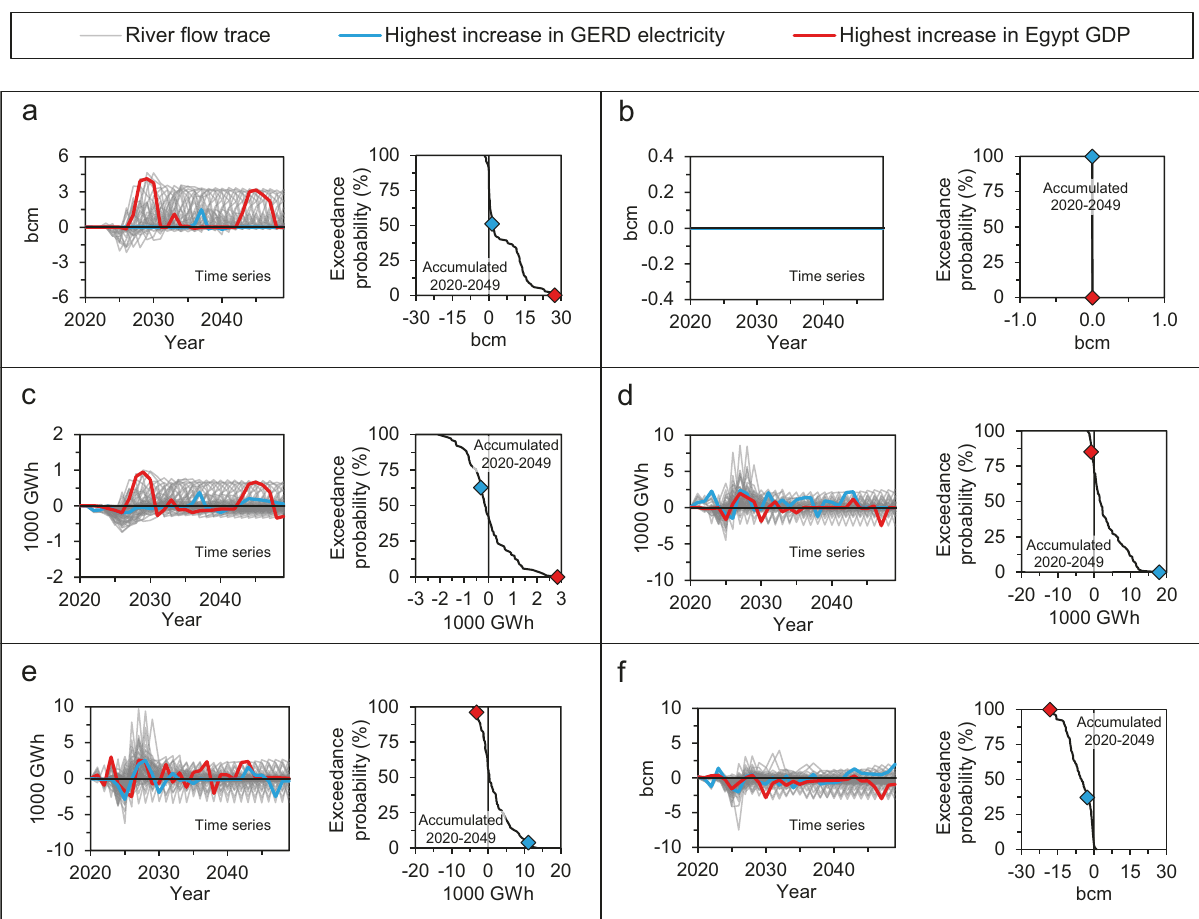
Fig. 3 Difference in simulated water and energy metrics between the coordinated operation and the Washington draft proposal. a Irrigation water withdrawal in Egypt. b Municipal water withdrawal in Egypt. c Hydropower generation in Egypt. d Electricity generation from the Grand Ethiopian Renaissance Dam. e System-wide electricity generation from hydropower. f Total evaporation from human-made reservoirs, Toshka spills, and river channel seepage. Positive values indicate higher simulated results with coordinated operation. The cyan- and red-colored points in the probability plots correspond to the cyan- and red-colored river fl ow traces, respectively. GDP gross domestic product, GERD Grand Ethiopian Renaissance Dam.